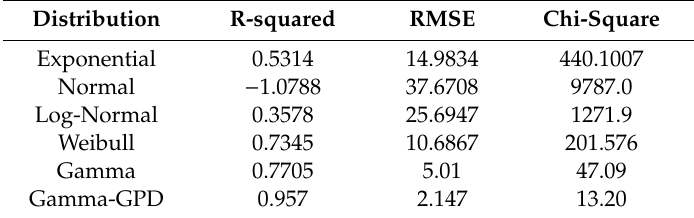
Table 6. The goodness of fit of various models under mid-century conditions (drought duration). Distribution